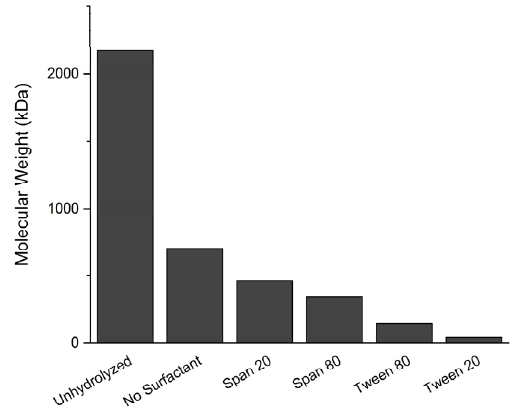
Figure 6. The effect of surfactant type on the molecular weight of the hydrolyzed chitosan. The chitosan’s concentration, surfactant concentration, and reaction time were 1% ( w / v ), 7% ( w / w ), and 24 h, respectively.